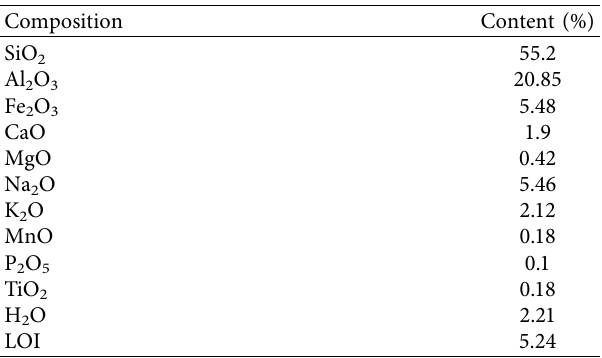
Table 3: Chemical compositions of volcanic ash.